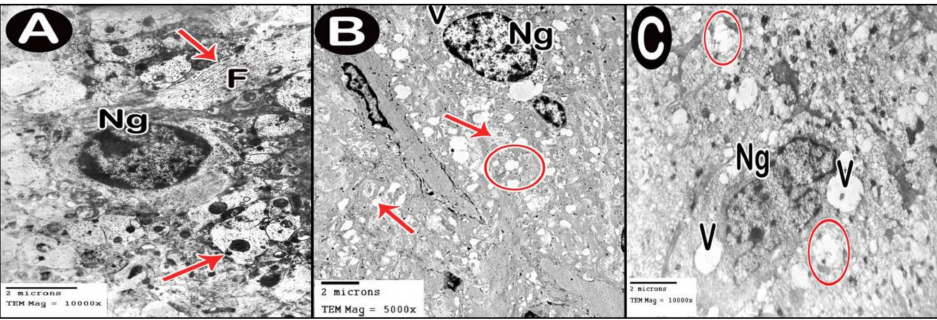
Figure 6. Electron micrographs of cerebellar cortex molecular layer. ( A ) control group. ( B ) low-dose group. ( C ) high-dose group. Axons (arrow), neurofilaments (F), neuroglia (Ng), vacuolated neuropil (circle) and vacuoles (V).